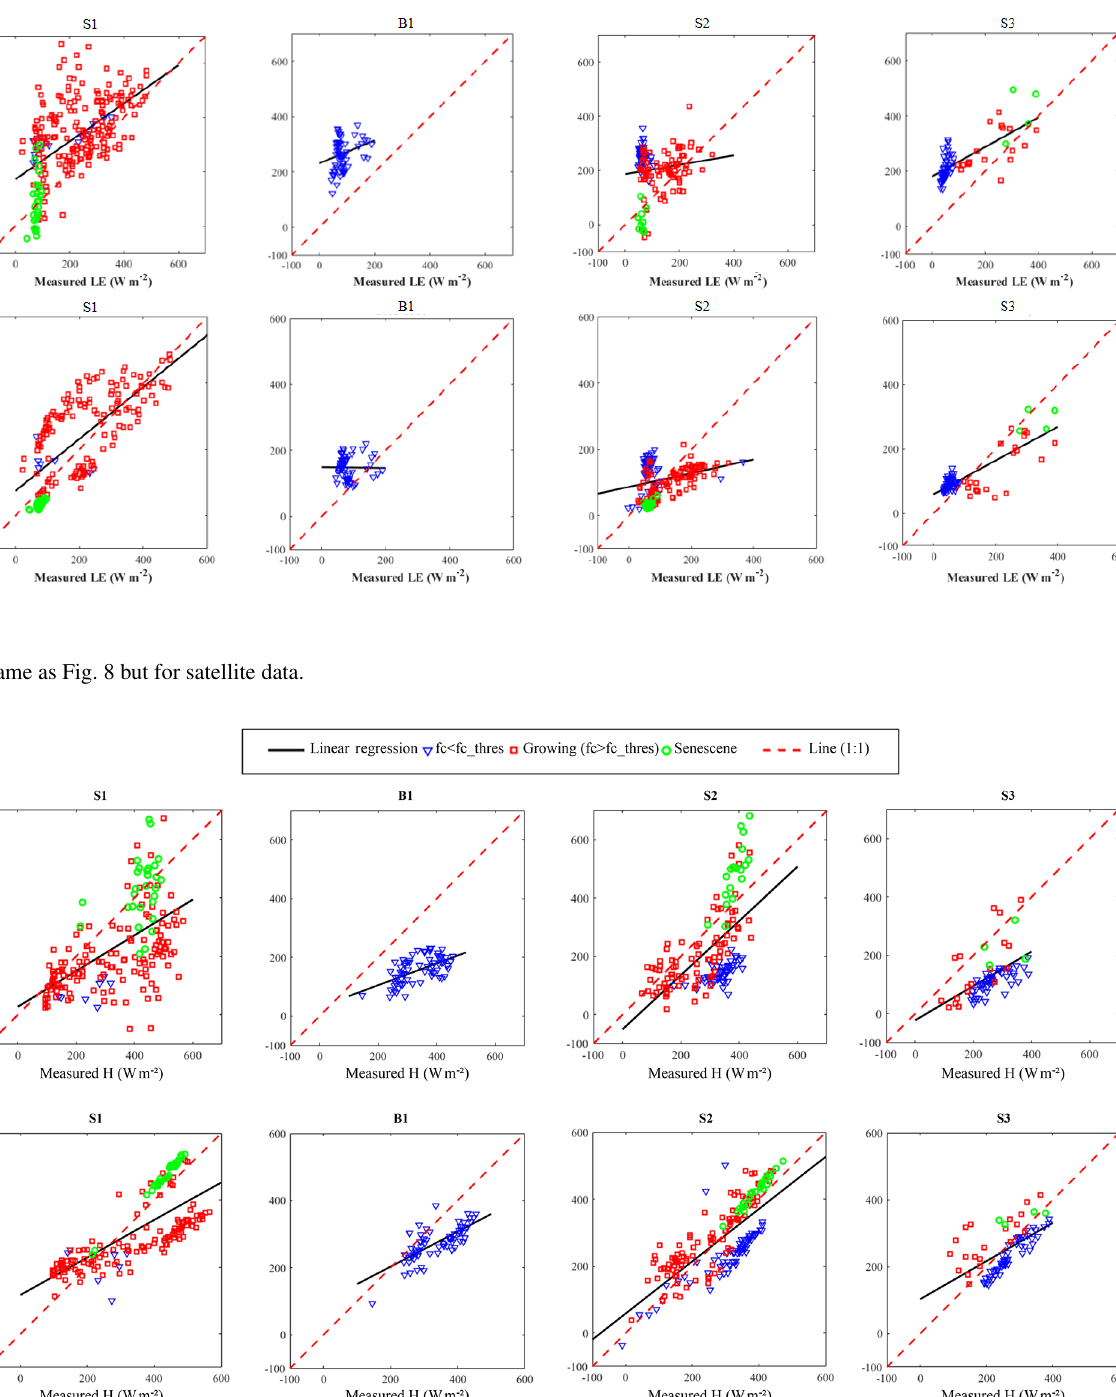
Figure 11. Same as Fig. 8 but for H fluxes and satellite